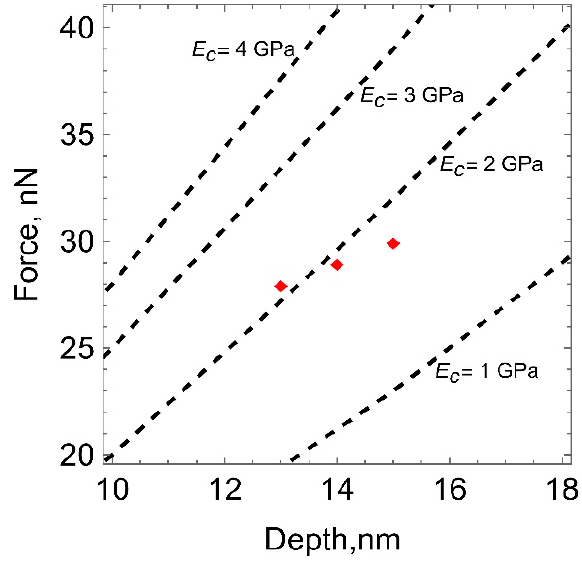
Figure 5. Theoretical curves of the indentation force versus penetration depth at different moduli of